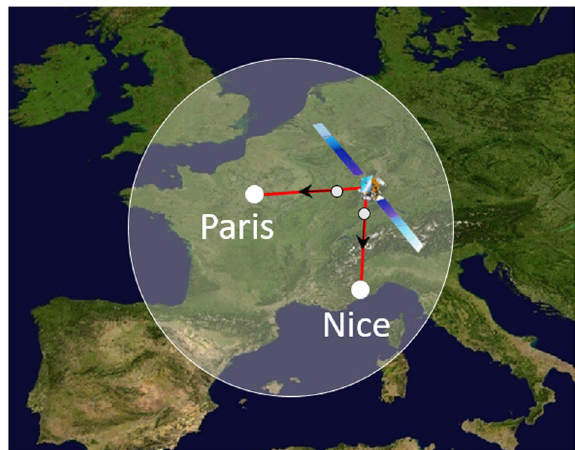
Fig. 5 Minimal system demonstrator. Space-to-ground entanglement distribution from a satellite towards two ground stations located in Paris and Nice, France. Base map source from